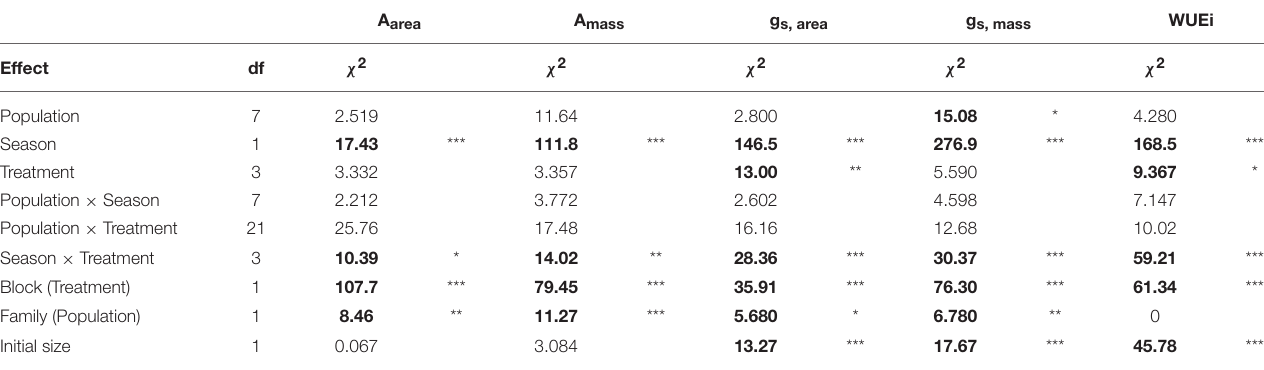
Block (Treatment) Family (Population) Initial size 1 262.2 Population, season, treatment and their interactions are fixed factors. Initial size is a covariate and block and maternal family are random factors. Degrees of Freedom (df), chi-square values( χ 2 )andsignificancePvalueswereobtainedfromlikelihood-ratiotestscomparingreducedmodelstothefullmodelusingfunction“anova”inlme4package. * P < 0.05, ** P < 0.01,